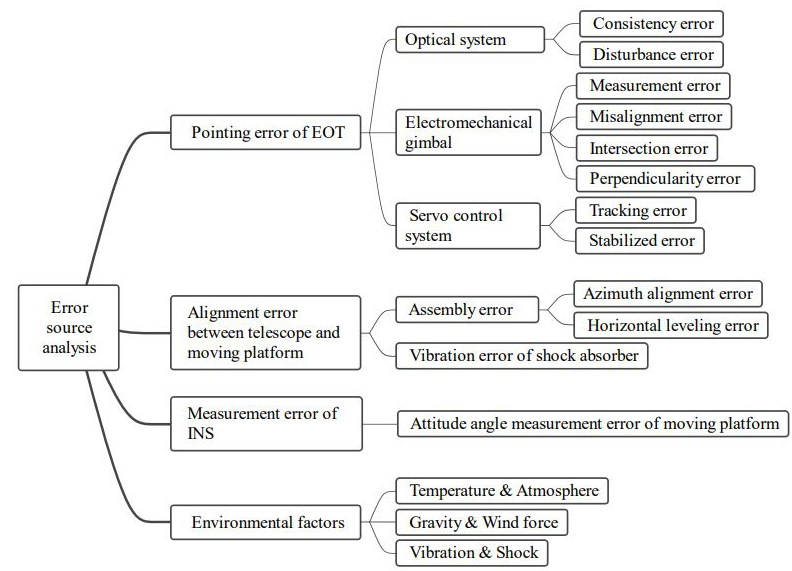
Figure 4. Error source